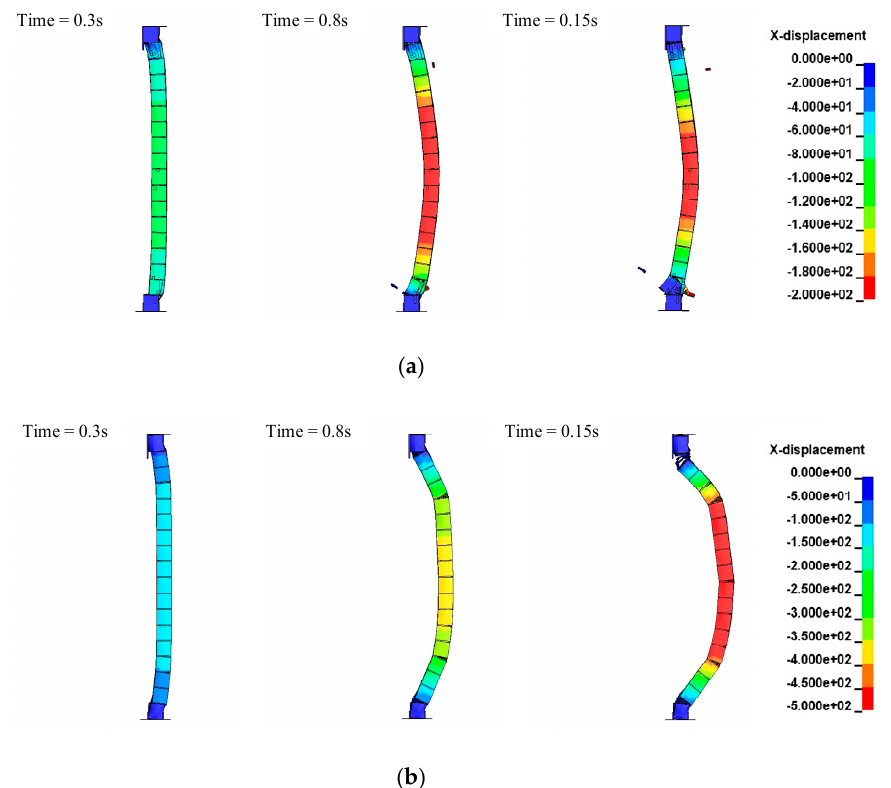
Buildings 2023 , 12 , x FOR PEER REVIEW 10 of 18